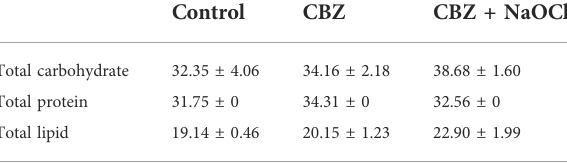
TABLE 2 Biochemical composition of microalgal